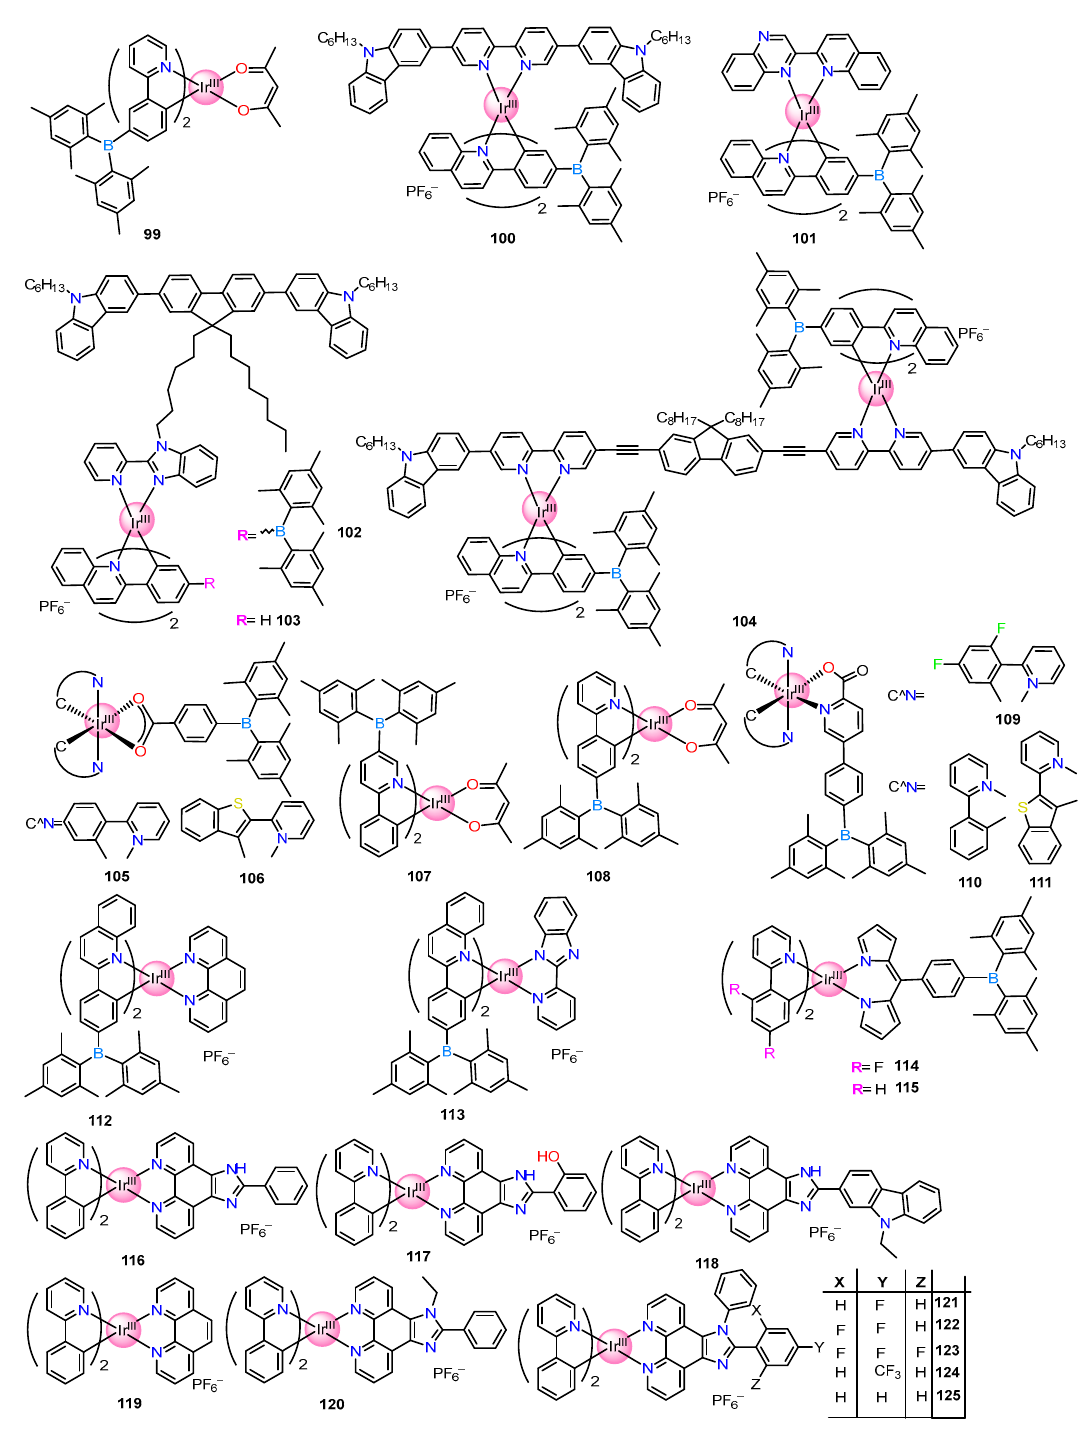
Figure 16. Structures of Ir(III) complexes 99 – 125